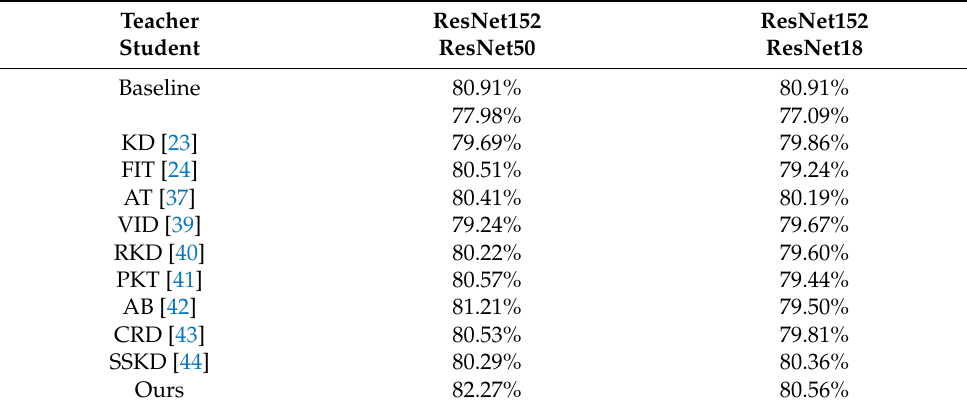
Table 6. Comparison of accuracy between the proposed and existing knowledge-distillation methods on